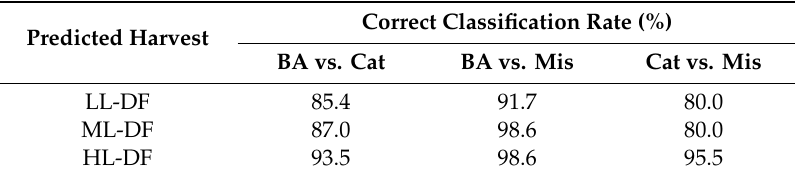
Table 2. PLS-DA classification results of HN2017, expressed as correct classification rates, according to the di ff erent DF strategies.